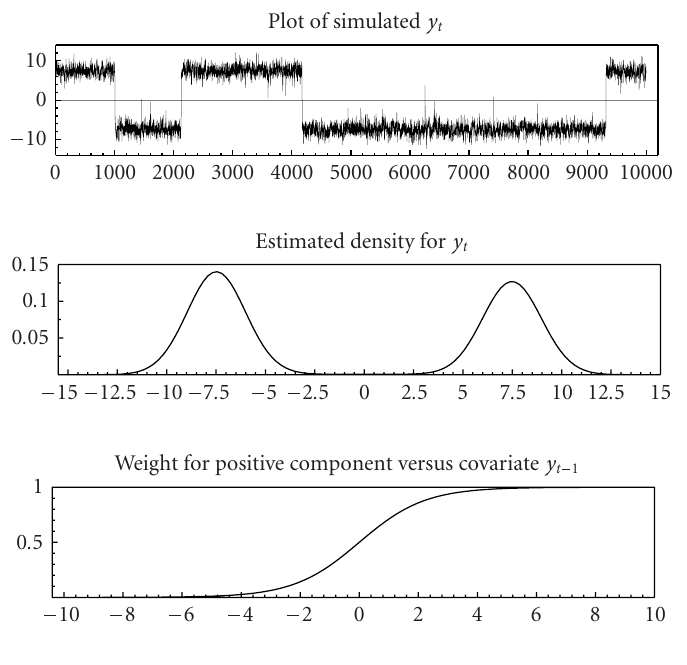
Figure 3.2. Generated time series (a), density estimate for the observed series (b), and weight g 1 ( y t − 1 ) for the positive mean autoregression (c) in the first example. The autoregressive coe ffi cient for each expert is assumed to be 0 .